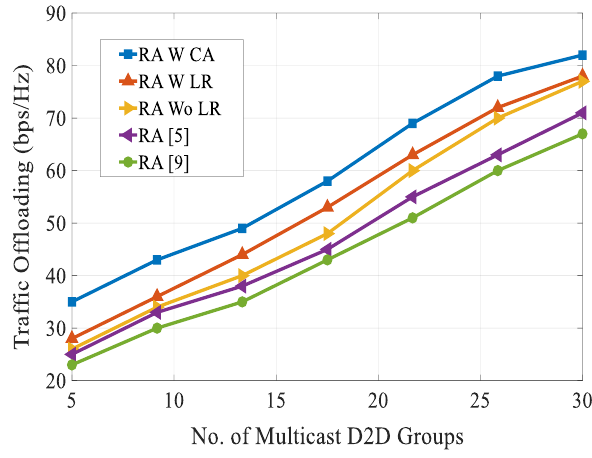
Figure 10. Traffic offloading vs. no. of multicast D2D groups.